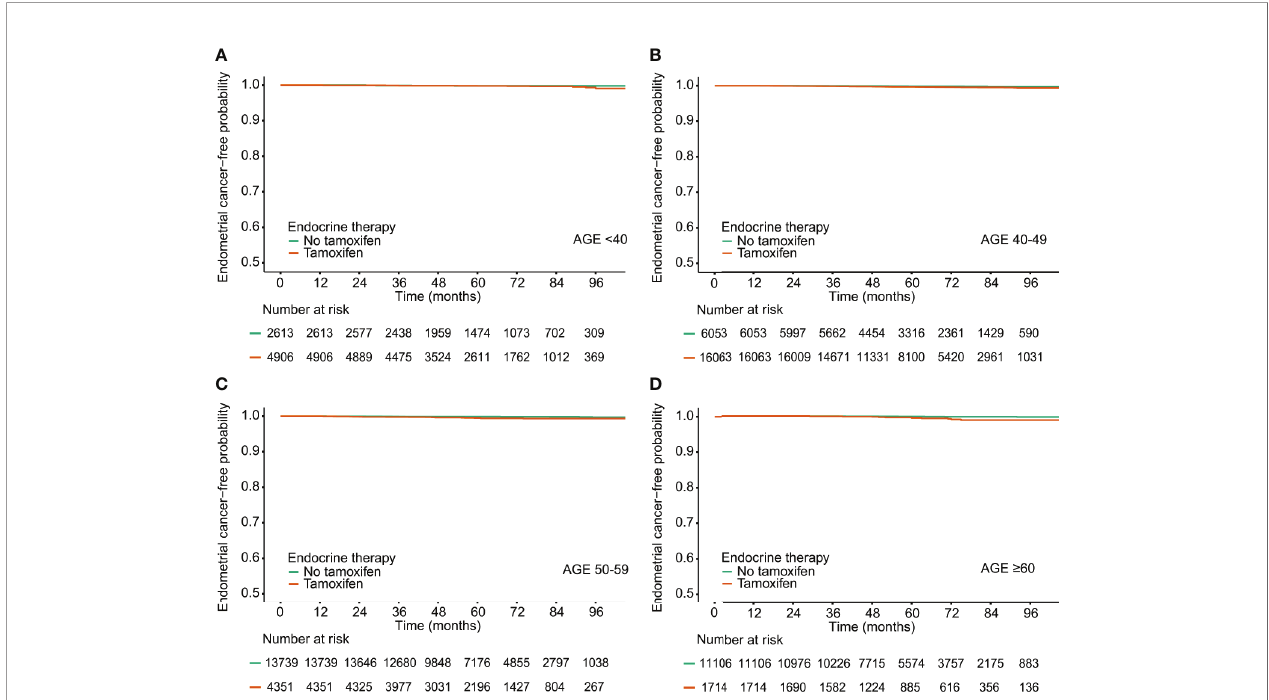
FIGURE 1 | Endometrial cancer-free probability in breast cancer survivors by tamoxifen and age at diagnosis. (A) Age<40, (B) Age 40-49, (C) Age 50-59, (D) Age <60.